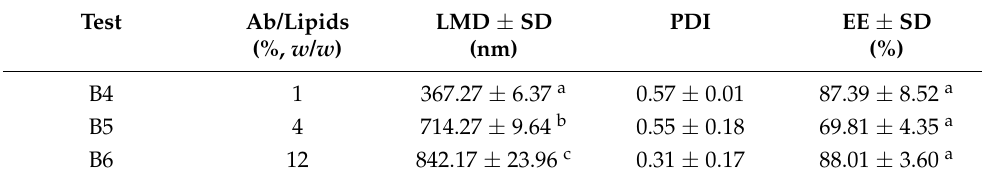
Table 4. Thin-layer hydration method experimental operative conditions and liposome character- ization parameters. Different letters (a, b, and c) in the LMD and EE column refer to statistically significant differences among the different samples of each column ( p < 0.05) by ANOVA with Tukey’s HSD post-hoc multiple comparison test. Ab/Lipids: antibody-to-lipid mass ratio, LMD: liposome mean diameter, SD: standard deviation, PDI: polydispersity index, EE: encapsulation efficiency.